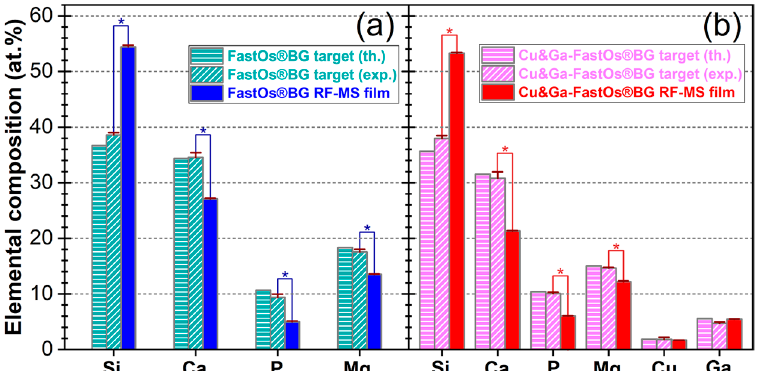
Figure 2. Comparative elemental composition (in at.%) of the magnetron cathode targets and the deposited silica-rich films: ( a ) FastOs ® BG- and ( b ) Cu&Ga-FastOs ® BG-based materials. The quantification of oxygen and fluorine was not performed because of the inaccuracy of EDXS analysis method with respect to light elements (Z < 11) [43]. * p < 0.05, statistically significant differences, as determined by using an unpaired two-tailed Student’s t -test.